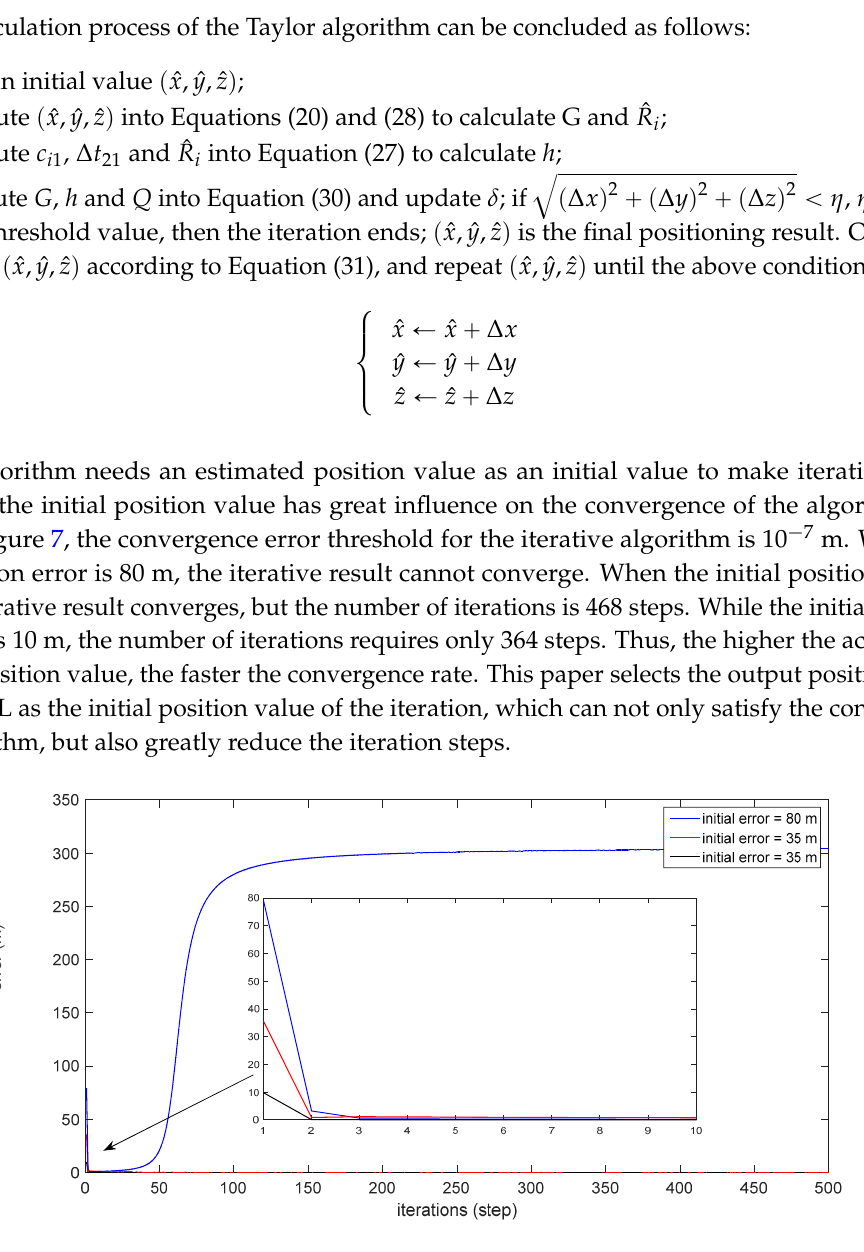
Figure 7. The iteration results with different initial position values.